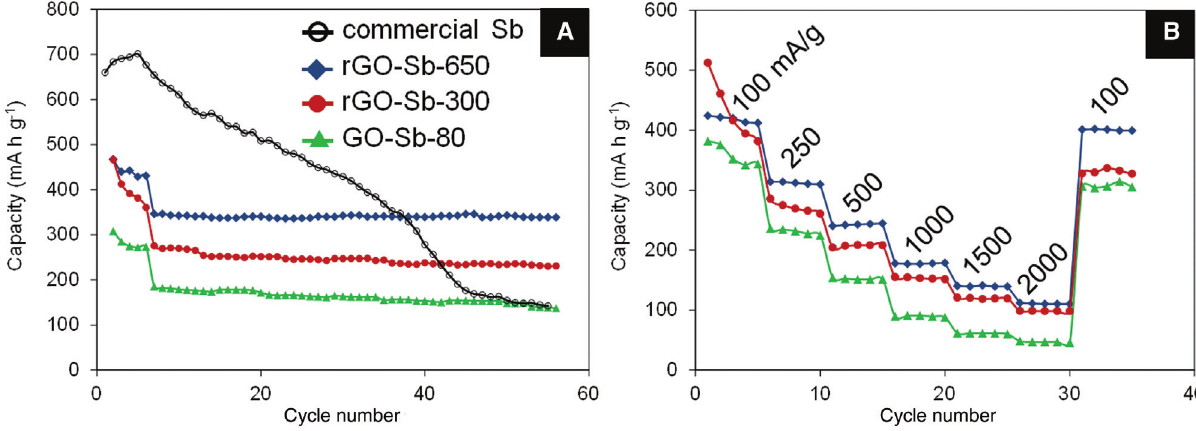
Figure 5: Cycle and rate performance of different antimony-based electrodes. (A) Charging capacities of commercial antimony oxide (open circles), rGO-Sb-650 (diamonds), rGO-Sb-300 (closed circles) and GO-Sb-80 (triangles). The first five cycles were conducted at a current density of 100 mA g -1 , and the others at 250 mA g -1 . (B) Charging capacities of rGO-Sb-650, rGO-Sb-300 and GO-Sb-80 at different charging rates. The specific mass used for the calculation is the total mass of the rGO-Sb composite (i.e., 60% of the electrode